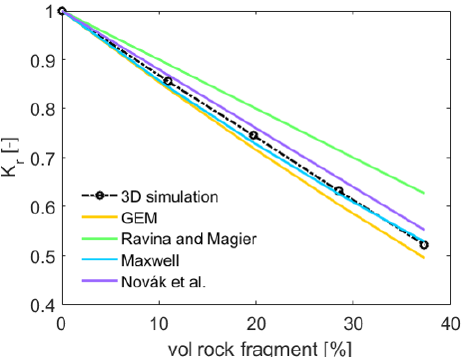
Figure 3. Comparison of the values of K r (–) from the virtual MSUG experiment in 3D (circles) as well as those calculated by different scaling models (solid lines) for f values up to 37.3%. The dashed line connects the simulated data points of K r shown by cir-